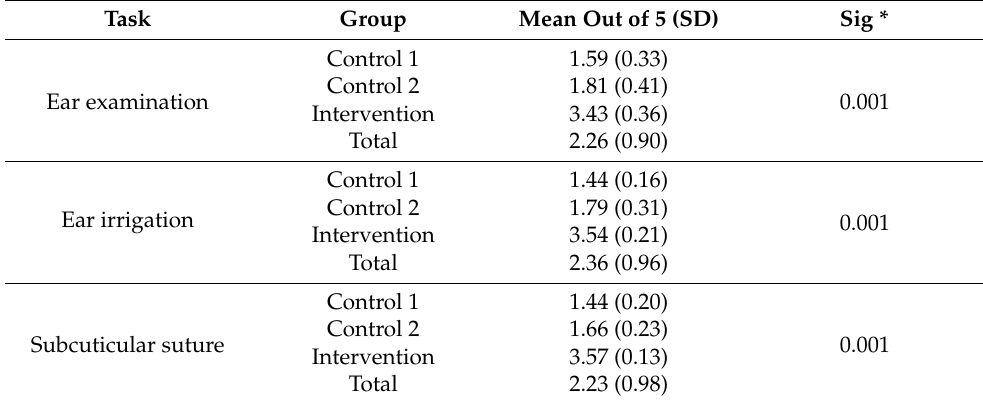
Table 3. Comparison of DOPS scores for each task among the study